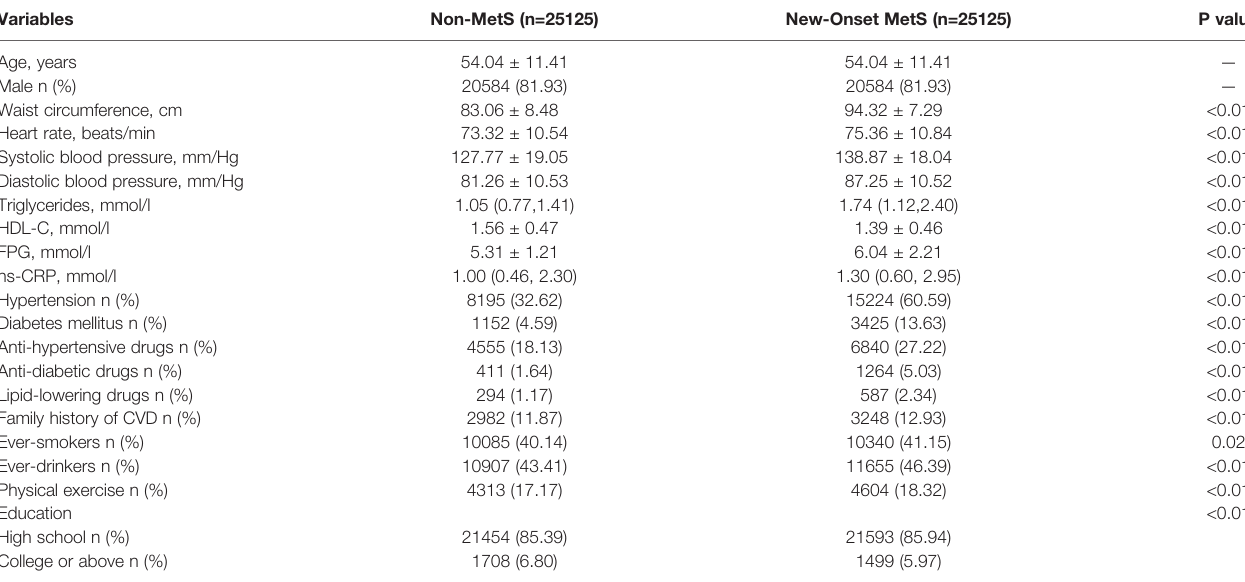
TABLE 1 | Basic characteristics for participants with new-onset MetS and their non-MetS controls.